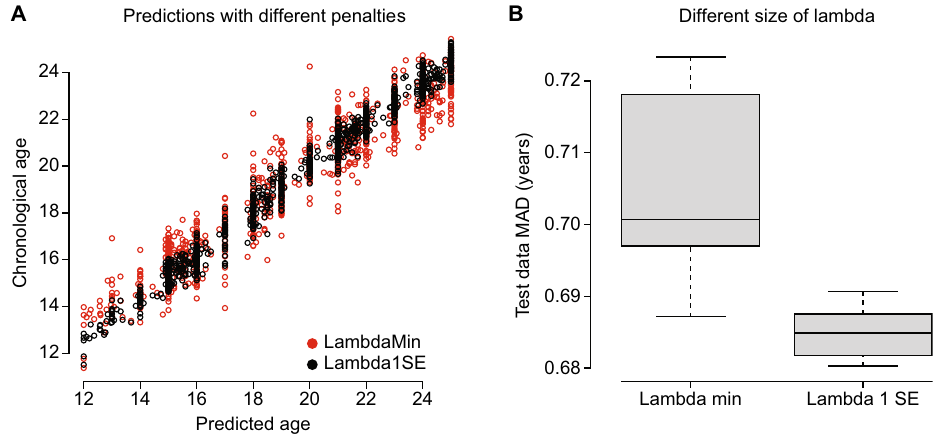
Figure 4. Choosing lambda. ( A ) Scatter plot of predicted and chronological age using different penalties (minimum lambda in black, one standard deviation lambda in red). ( B ) Prediction performance on independent test dataset using the same lambdas.